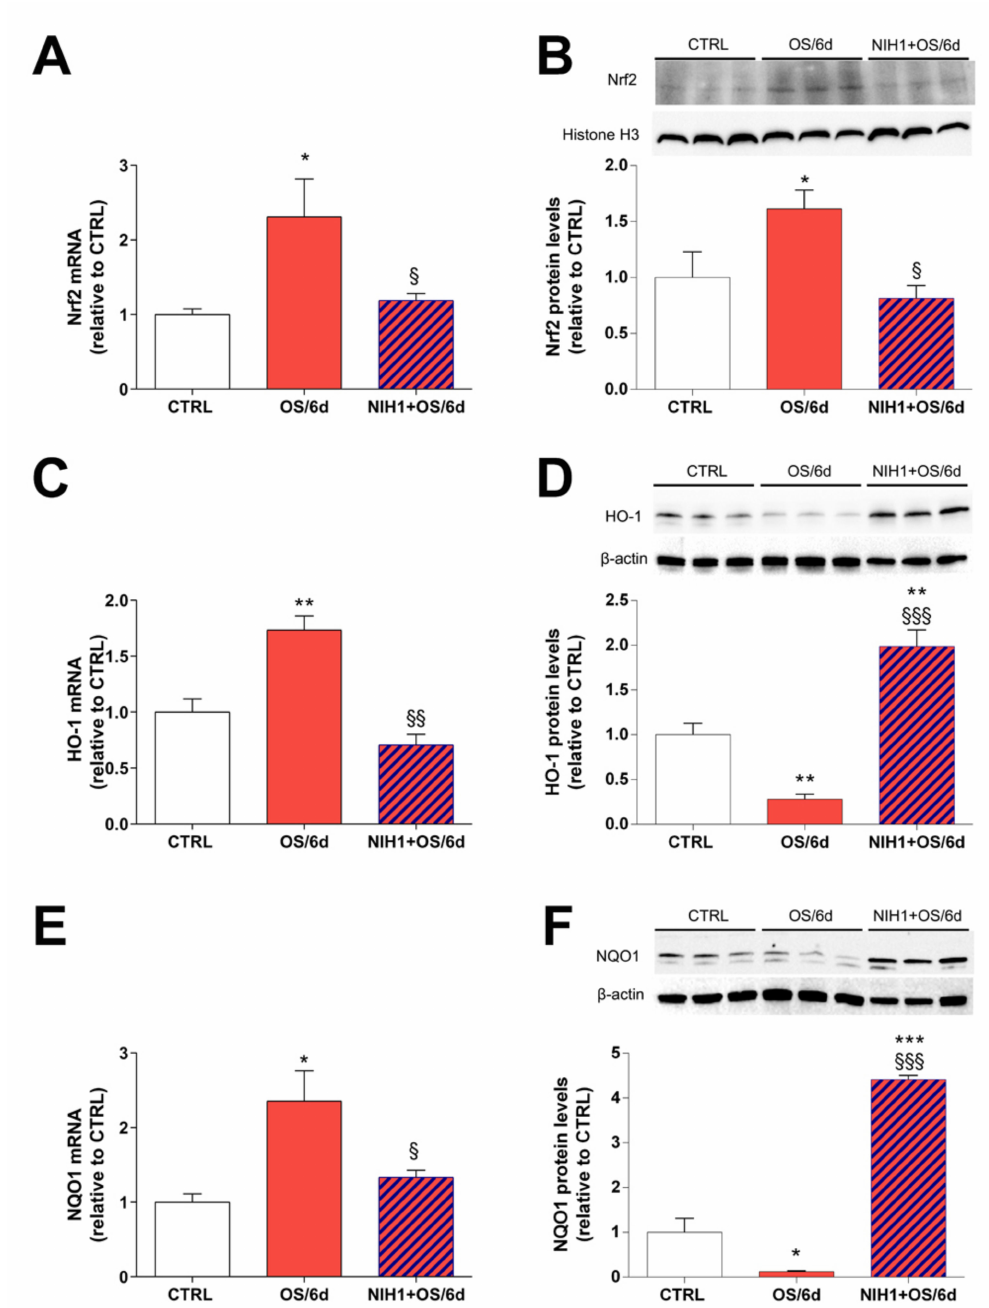
Figure 6. Long-term antioxidant effect of NIH1 in retinal explants treated with NIH1 for six days. The mRNA levels of ( A ) Nrf2, ( C ) HO-1, ( E ) NQO-1 were evaluated with qPCR in CTRL, in OS/6d, and in NIH1 + OS/6d explants. ( B ) Western blot analysis of nuclear protein fraction showing representative immunoreactive bands and quantitative densitometric analysis of the Nrf2 protein levels in CTRL, OS/6d and NIH1 + OS/6d explants. ( D , F ) Western blot analysis of total protein fraction showing representative immunoreactive bands and quantitative densitometric analysis of the HO-1and NQO1 protein levels in CTRL, OS/6d and NIH1 + OS/6d explants. One-way ANOVA, n = 3; * p < 0.05, ** p < 0.01, *** p < 0.001 vs. CTRL; § p < 0.05, §§ p < 0.01, §§§ p < 0.001 vs.